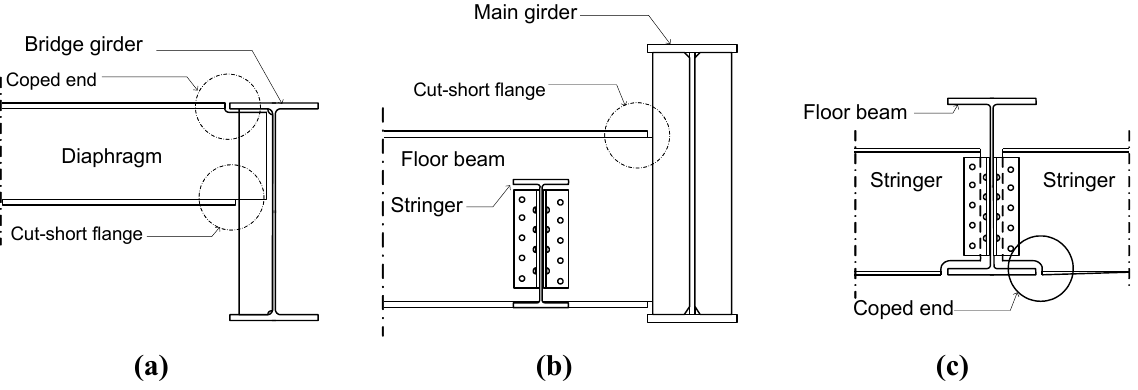
Figure 20. Examples of bridge elements with coped ends or cut-short flanges: ( a ) diaphragm; ( b ) floor beam; and ( c ) stringer.